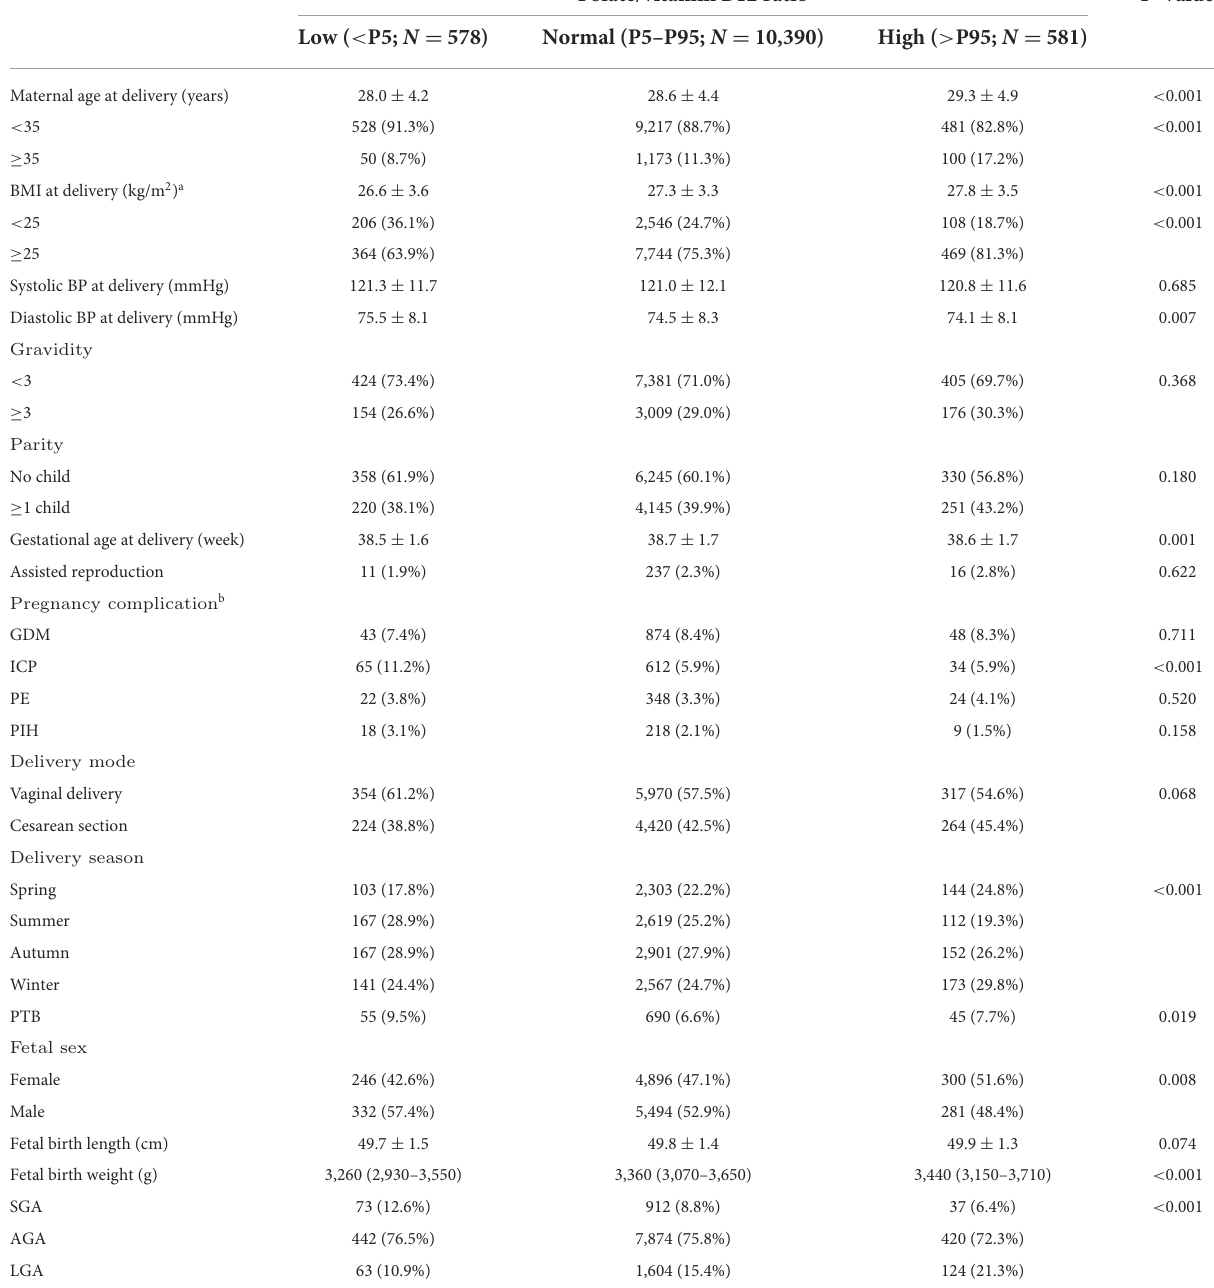
TABLE 1 Characteristics of study populations according to the categories of maternal serum folate/vitamin B12 ratio during late pregnancy. Folate/vitamin B12 ratio P- Value Low ( < P5; N = 578) Normal (P5–P95; N = 10,390) High ( > P95; N =